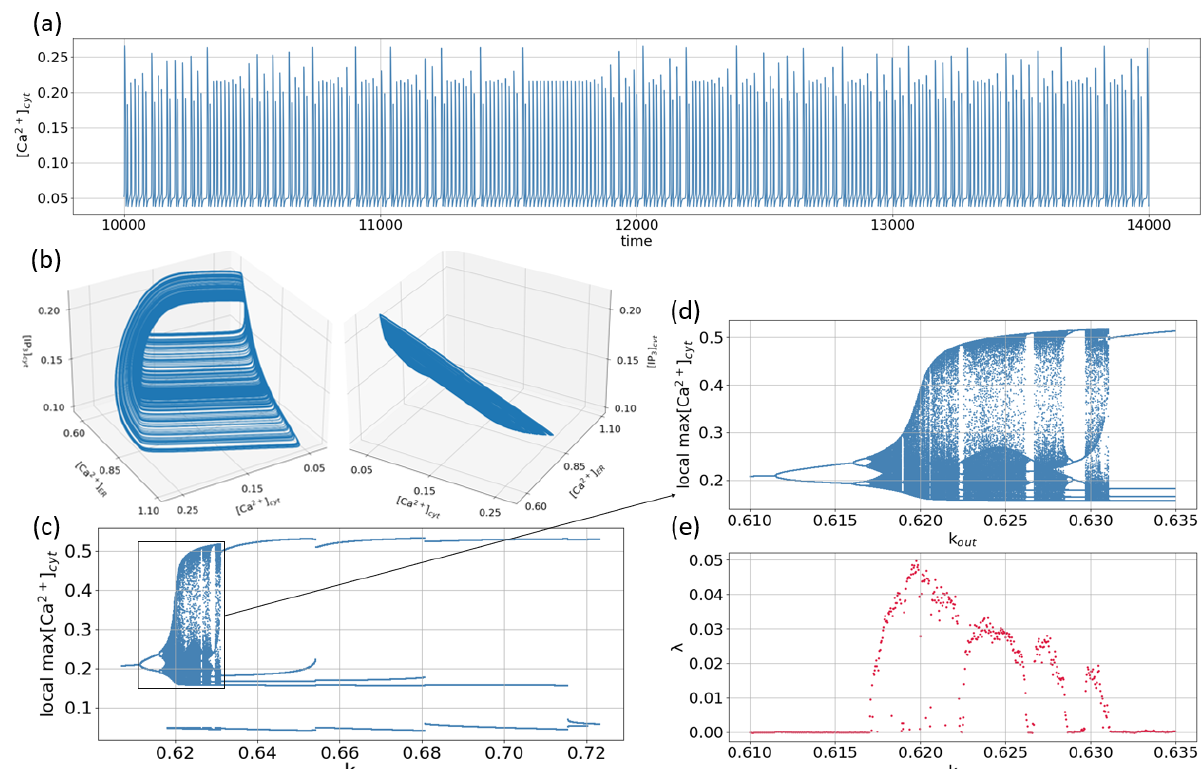
Figure 7. ( a ) Time series of [ Ca 2 + ] cyt ; and ( b ) corresponding phase portraits obtained for J in = 0.05 µ M/s, v M 2 = 15 µ M/s, v M 3 = 40 s − 1 , v p = 0.05 µ M/s, k CaA = 0.27 µ M, k CaI = 0.27 µ M, k p = 0.133 µ M, k ip 3 = 0.1 µ M, k deg = 0.08 s − 1 , k out = 0.618 s − 1 , k f = 0.5 s − 1 ; ( c ) One-parametric bifurcation diagram shows the local maxima of [ Ca 2 + ] cyt obtained for various values of the parameter k out within the time interval t ∈ [10,000, 15,000]; for each value of k out , the initial conditions are ( 0.1,1.5,0.1 ) ; ( d ) Enlargement of the squared part of the one-parametric bifurcation diagram given in ( c ); ( e ) The maximal Lyapunov exponent as function of the parameter k out